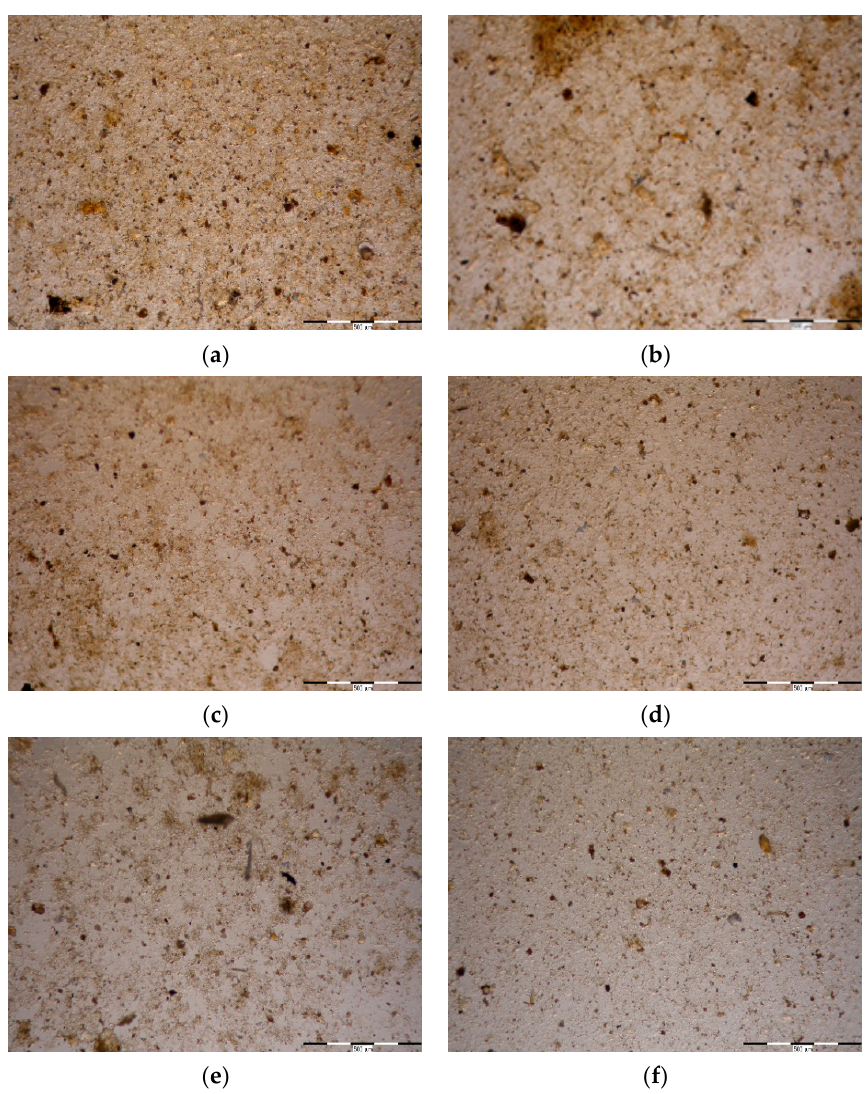
Figure 9. Structure of non-pretreated excess sludge ( a ) and structure of excess sludge chemically disintegrated with the reagent with the selected doses: 0.5 mL STERIDIAL W-10/L ( b ), 1.0 mL STERIDIAL W-10/L ( c ), 2 mL STERIDIAL W-10/L ( d ), 3 mL STERIDIAL W-10/L ( e ), and 8 mL STERIDIAL W-10/L ( f ) sludge for 1